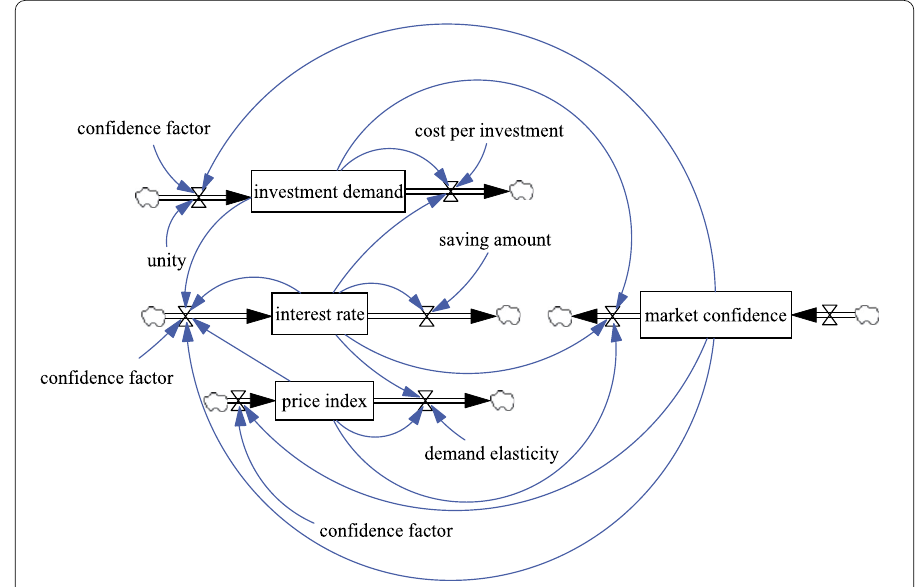
Figure 2 Schematic diagram of financial system (2) with market confidence